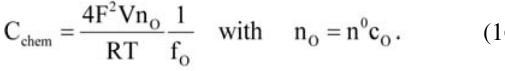
tors, based on Sr-doped LaFeO films under reducing conditions can be found in Refs.